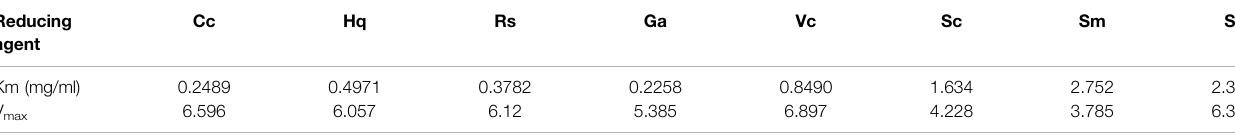
TABLE 3 | Km and Vmax with H 2 O 2 as substrate.